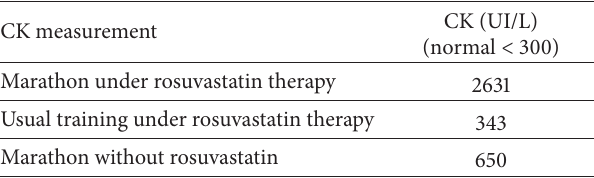
Table 1: Muscle enzyme (creatine kinase, CK) levels during training under rosuvastatin, during a marathon under rosuvastatin, and during a second marathon without